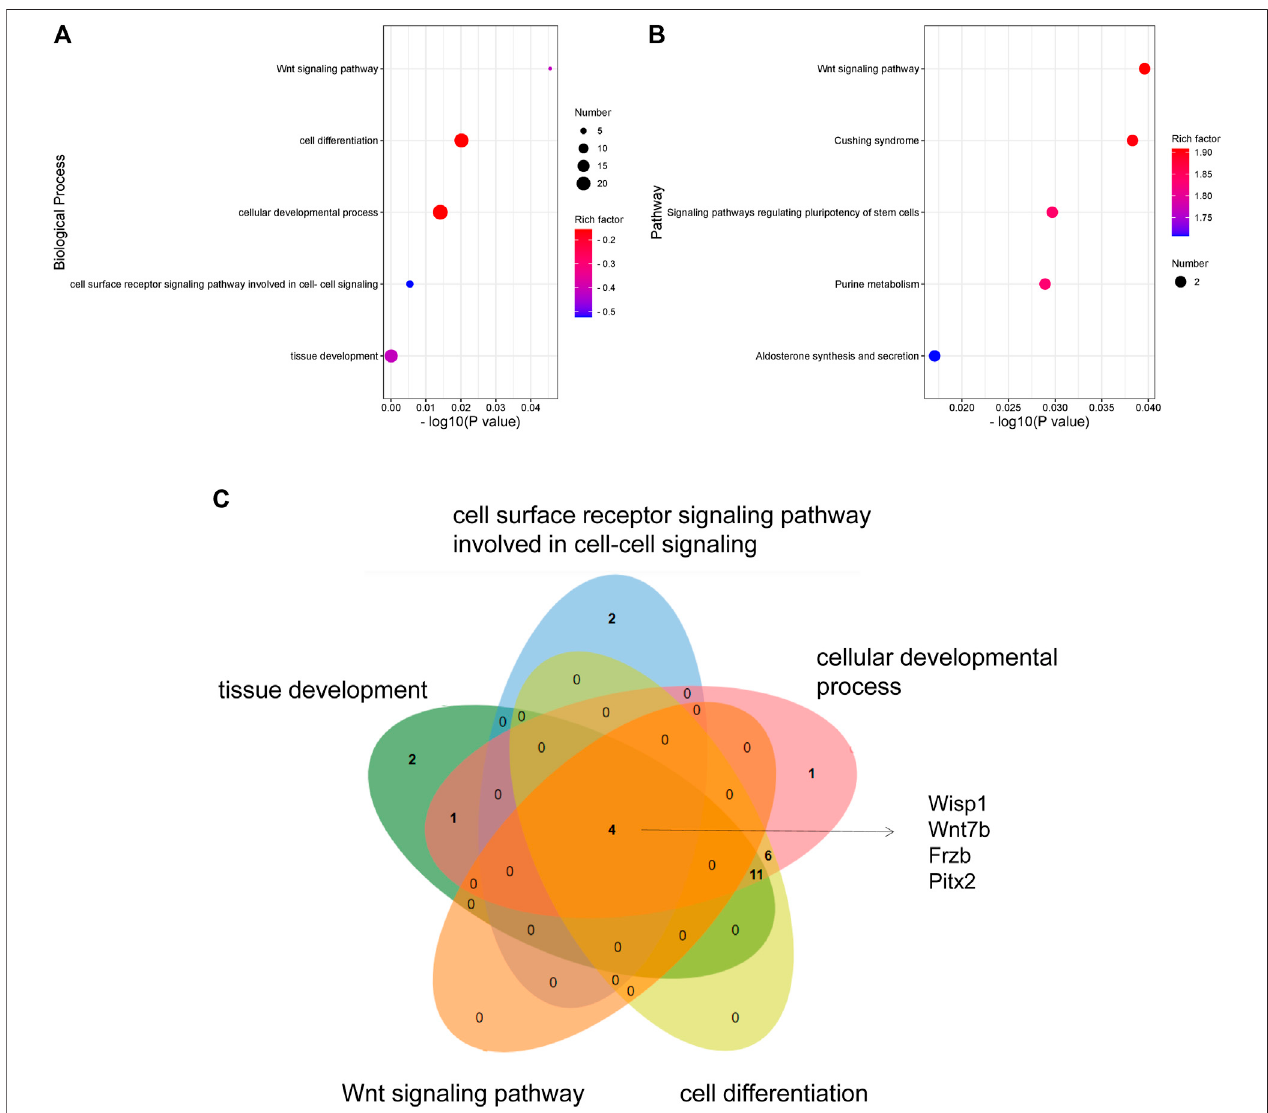
FIGURE 5 | GO and KEGG analyses of DEGs: (A) GO enrichment of DEGs. (B) KEGG pathway enrichment of DEGs. (C) Venn diagram showing the overlapping signi fi cant DEGs from GO terms.